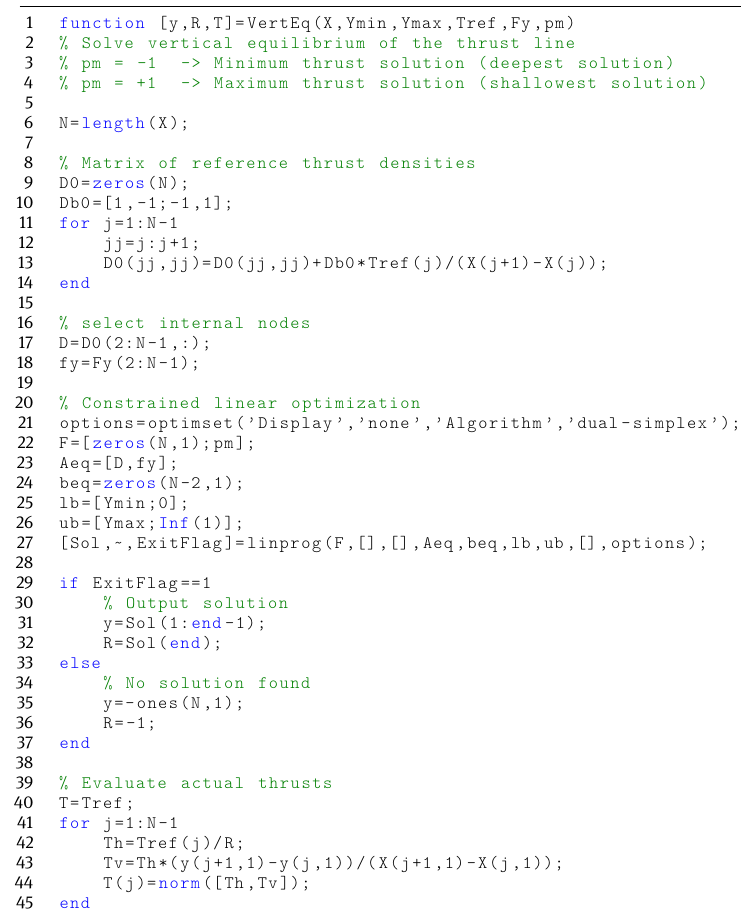
Figure 4: MATLAB function VertEq: solution of the vertical equilibrium of a thrust line